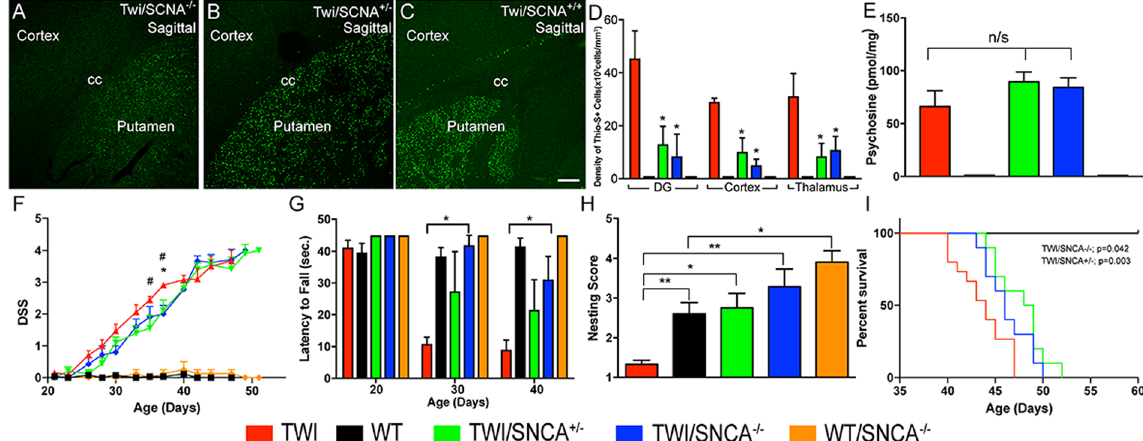
Figure 1. Knock-out of SNCA removes thioflavin-S-positive inclusions in certain brain regions and improves survival and behavior of TWI mice. ( A ) Brain tissue from TWI/SCNA − / − ( A ), TWI/SCNA + / − ( B ) and TWI/ SCNA + / + ( C ) were stained for thioflavin-S-positive protein aggregates. Thio-S material was visibly reduced in the lower cortical layers and putamen of TWI/SNCA − / − brains ( A ) and TWI/SNCA + / − brains ( B ) with respect to TWI/SNCA + / + ( C ). Images ( A – C ) show anatomical regions encompassing deep cerebral cortex and the putamen. cc, corpus callosum. Scale bar = 200 μ m. ( D ) Unbiased stereology quantitatively revealed a significantly reduced abundance of thio-S + material in TWI/SNCA − / − and TWI/SNCA + / − brains (p = 0.001, ANOVA) within the Dentate Gyrus (DG), Cerebral Cortex (Cortex), and Thalamus. ( E ) Psychosine levels measured using LC-MS-MS showed non-significant (n/s) changes between the presence or absence of the SCNA allele in TWI brains. ( F ) A disease severity score (DSS) measured less severe signs in TWI/ SNCA + / − and TWI/SNCA − / − mice compared to TWI/SNCA + / + , while changes were significant at only P36 and P38 for TWI/SNCA + / − ( * p < 0.05) and P36 for TWI/SNCA − / − ( * p < 0.05). ( G ) Grip strength, as assessed by a latency-to-fall test, was significantly improved in TWI/SNCA − / − compared to TWI/SNCA + / + at P30 ( * p < 0.05). ( H ) Nesting ability score, assessed at P20 in each genotype group, was significantly improved in both TWI/SNCA + / − and TWI/SNCA − / − compared to TWI mice ( * p < 0.05, ** p < 0.01, ANOVA). ( I ) Kaplan-Meier survival curves reveal significantly longer life of TWI/SNCA + / − and TWI/SNCA − / − compared to TWI. N = 10 mice (TWI/SNA + / − and TWI/SNCA − / − ) N = 15 mice (TWI/SNCA + / +